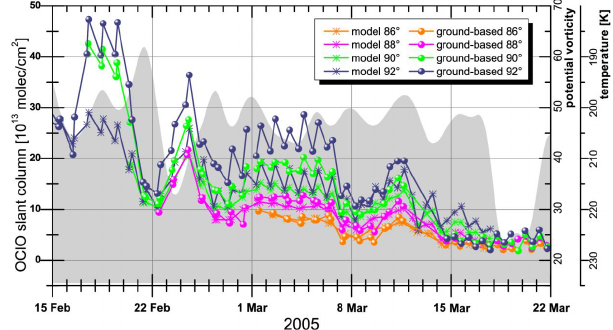
Figure 6. Model (asterisks) and measurements (dots) of OClO at Ny-Ålesund (79°N, 12°E) at four different SZAs (see box embedded in figure; axis on the left). Potential vorticity (shaded area) and temperature (black line) at the 475 K isentropic surface are also shown. Note that the zigzag pattern in the curves for high SZAs is caused by the diurnal variation of OClO with higher concentrations in the afternoon.